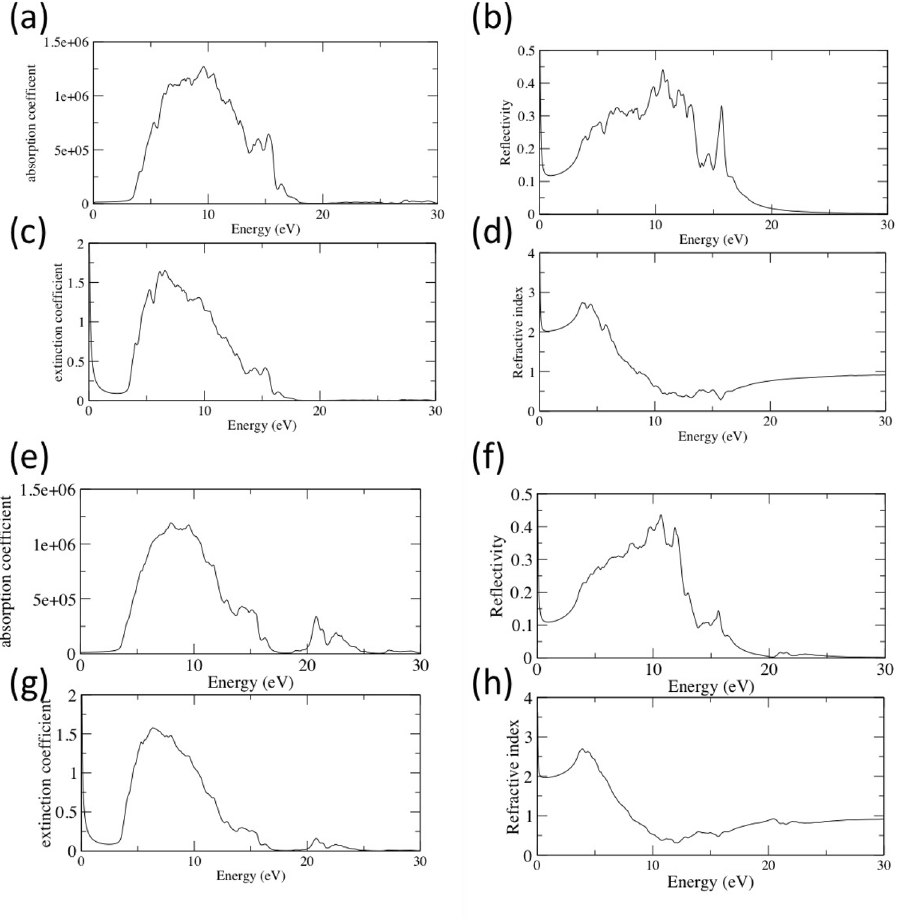
Figure 7. The calculated of ( a ) absorption coefficient ( b ) reflectivity, ( c ) extinction coefficient and ( d ) refractive index of pristine BGO. The lower panel presents ( d ) absorption coefficient ( e ) reflectivity, ( f ) extinction coefficient and ( g ) refractive index of Ce-doped